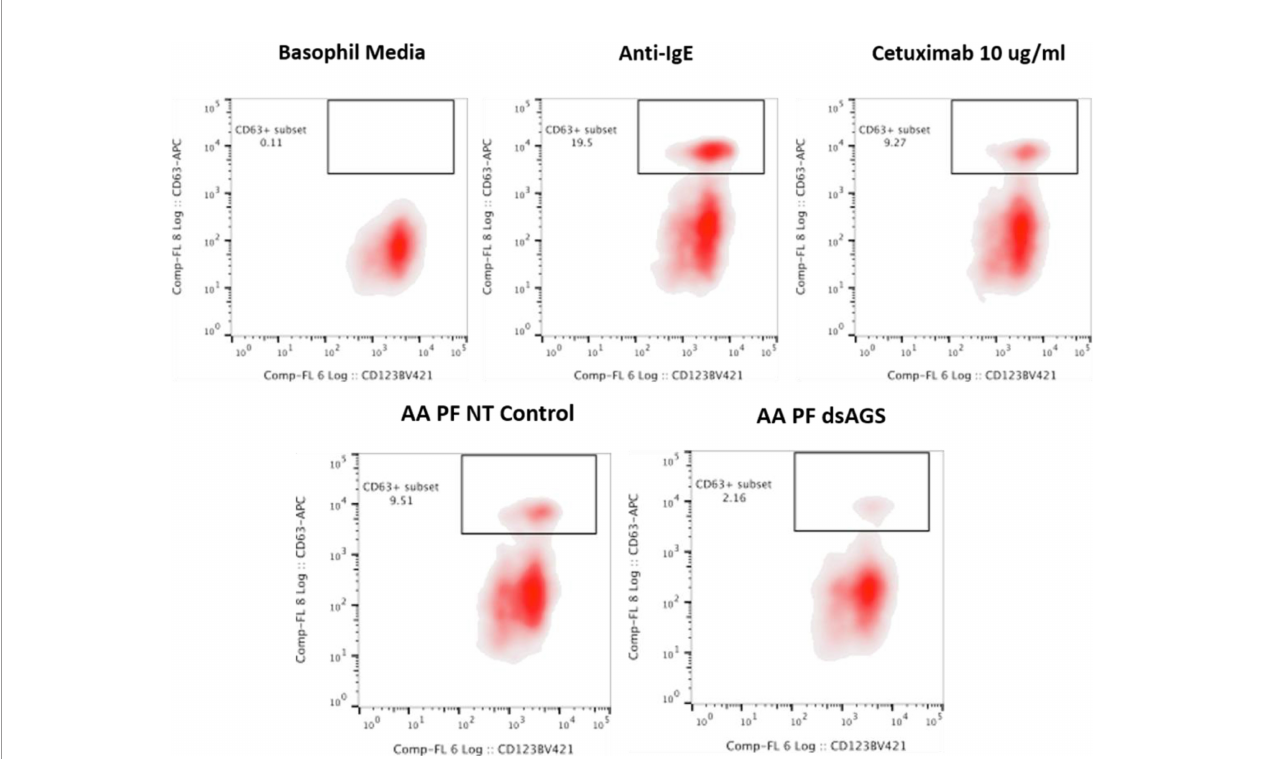
FIGURE 4 | Flow cytometric analysis of human basophil activation by Amblyomma americanum salivary proteins (pooled salivary gland, N=5 ticks). Donor basophils from a healthy, non-allergic control subject were stripped of IgE and primed overnight with plasma from a subject with a -gal syndrome ( a -gal sIgE = 31.3 IU/ml, total IgE = 233 IU/ml). Sensitized cells were exposed to one of the following stimuli for 30 min: RPMI media, crosslinking anti-IgE antibody (Positive control), a -gal- containing glycoprotein, cetuximab ( a -gal positive control), partially-blood-fed Am. americanum control, and a -D-galactosidase-gene-silenced salivary gland extracts treated. CD63 expression on lineage-HLA-DR-CD123+CD203c+basophils was assessed by fl ow cytometry. Results are representative of two biological